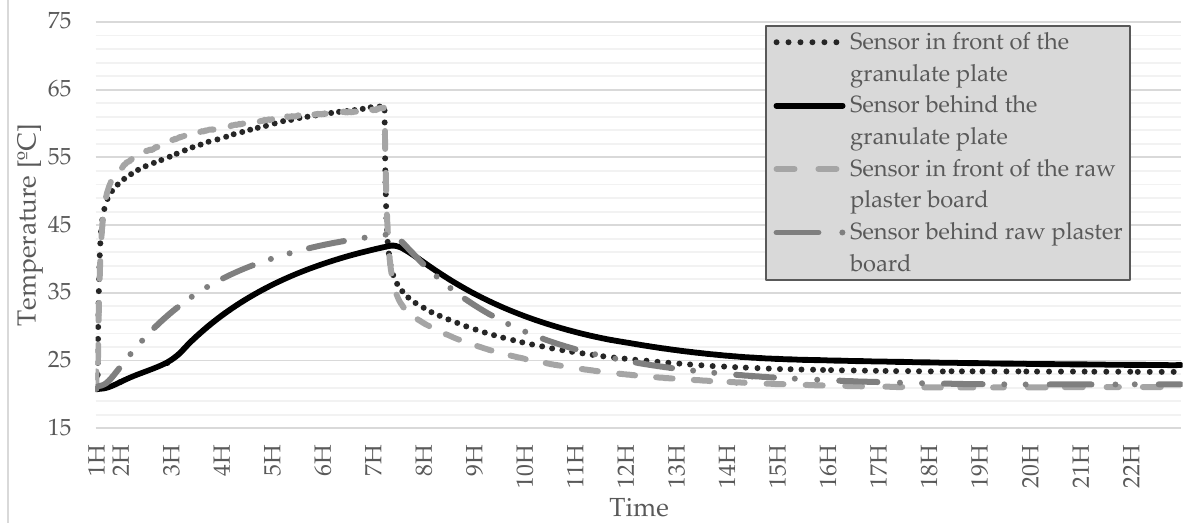
Figure 9. Change of temperature as a function of time for a PCM gypsum board and a raw gypsum board.